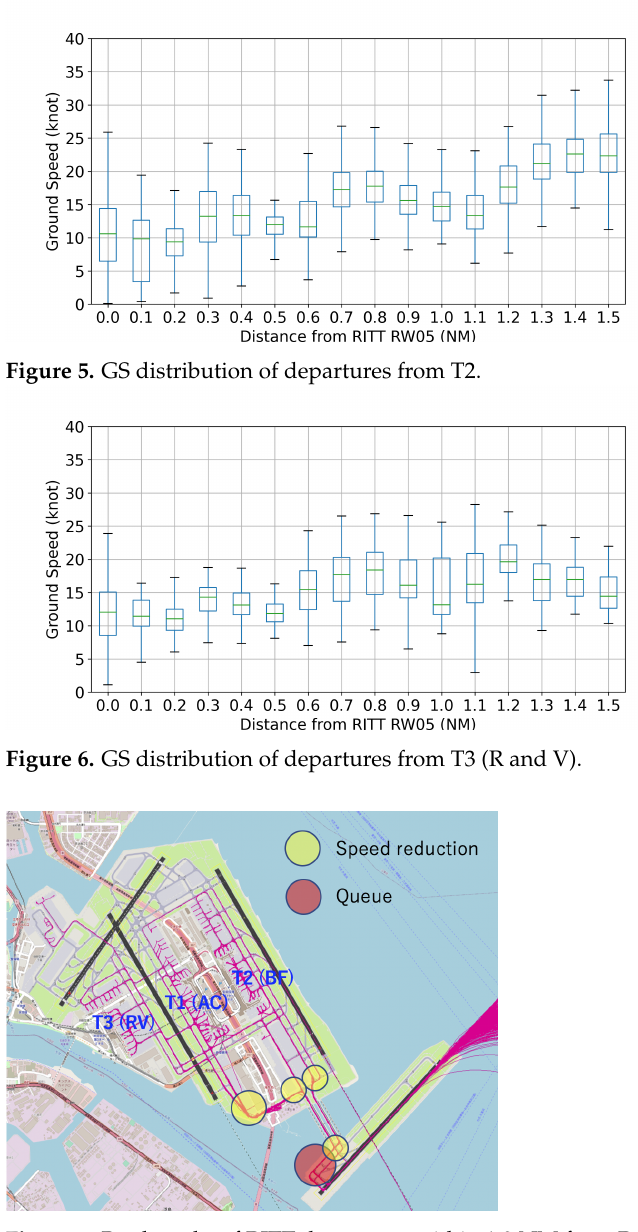
Figure 7. Bottlenecks of RJTT departures within 1.0 NM from Runway 05 entry